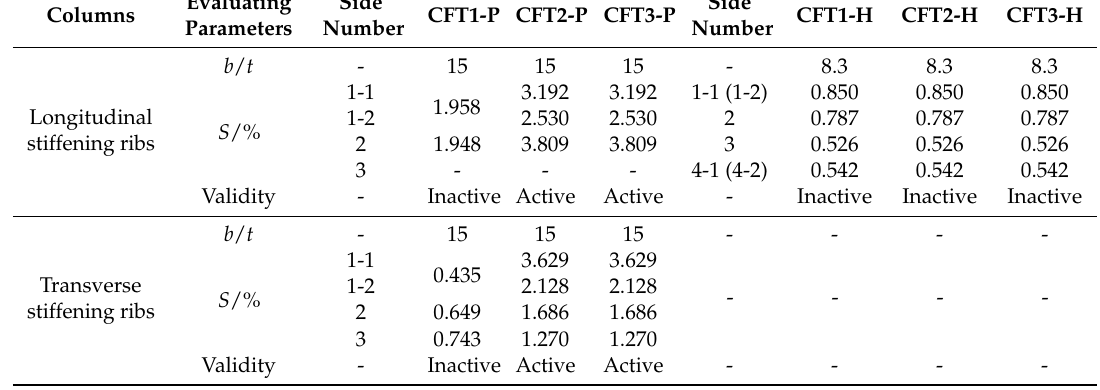
Table 4. The validity determination of stiffening ribs.